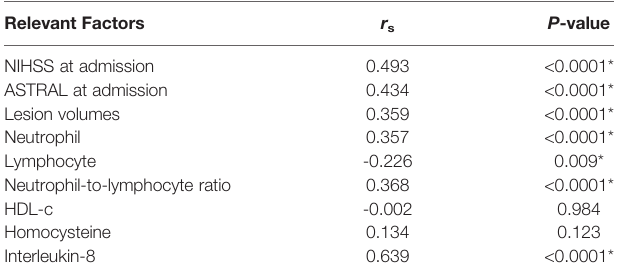
TABLE 1 | Analysis of relative factors of TSG-6 plasma level in non-cardioembolic AIS